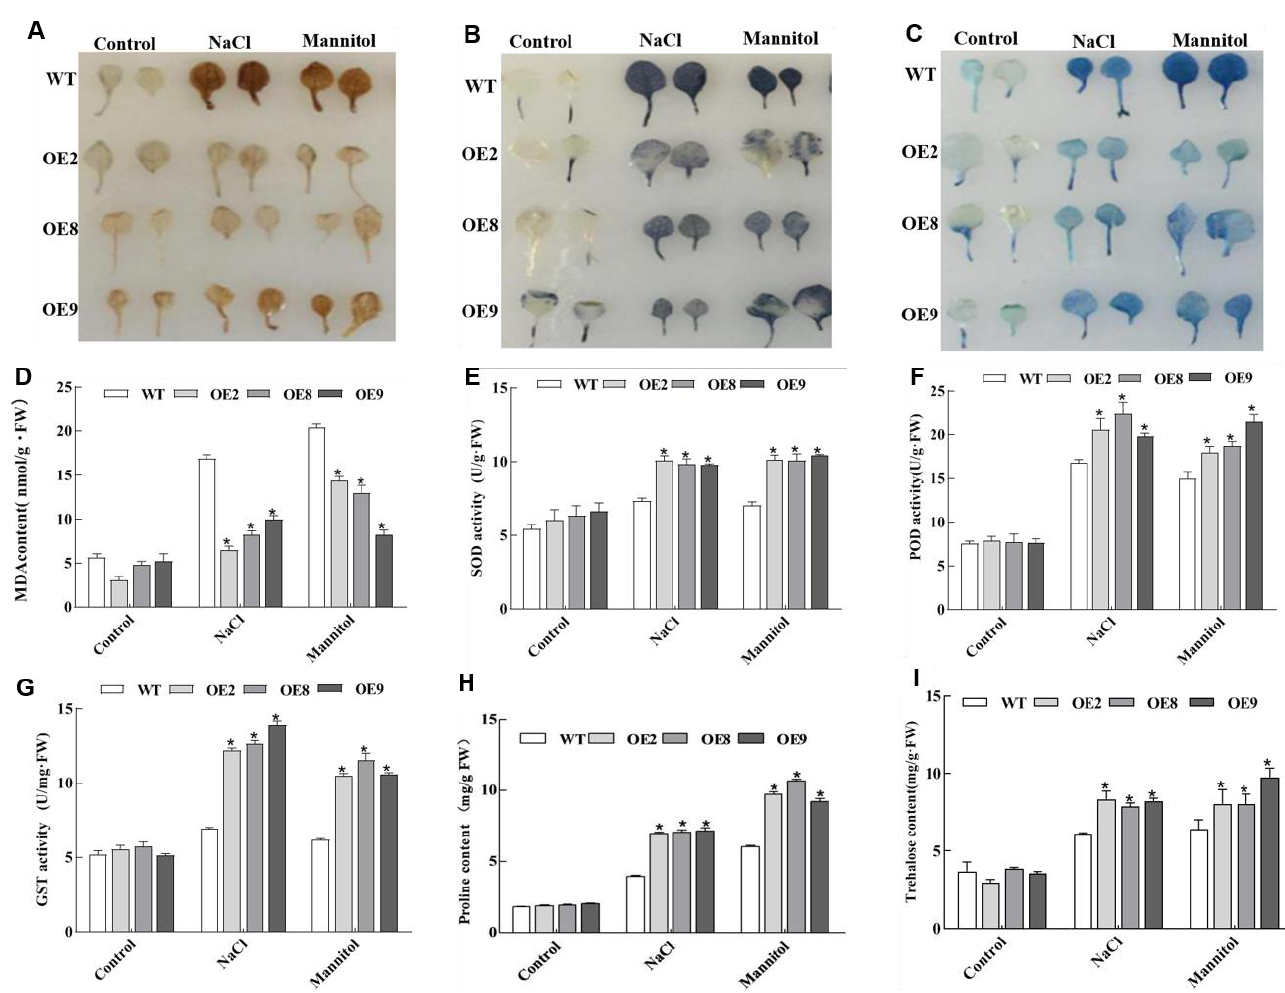
Figure 4. Histochemical staining and physiological analysis of ThNAC4 -transformed and WT Arabidopsis plants. ( A ), ( B ) Detection of ROS levels in ThNAC4 -transformed (Lines 2, 8, and 9) and WT plants. Leaves from transgenic lines and WT plants untreated and treated with 150 mM NaCl or 200 mM mannitol for 2 h were used for histochemical staining by NBT and DAB to reveal the accumulation of O 2- and H 2 O 2 , respectively. ( C ) Evans blue staining analysis of cell death. Leaves sampled from 4-week-old transgenic and WT seedlings untreated and treated with 150 mM NaCl or 200 mM mannitol for 2 h were used for histochemical staining. ( D ), ( E ), ( F ), ( G ), ( H ), ( I ) Physiological analysis of ThNAC4 -transformed and WT Arabidopsis plants. Four-week-old seedlings of transgenic lines and WT plants were irrigated with 150 mM NaCl or 200 mM mannitol for 2 days to measure MDA contents ( D ); SOD ( E ), POD ( F ), and GST ( G ) activities; and proline (H) and trehalose ( I ) contents. The error bars represent the standard deviations of the mean measurements, which were calculated from three independent experiments. * indicates a significant difference ( p < 0.05) between transgenic lines and WT plants.